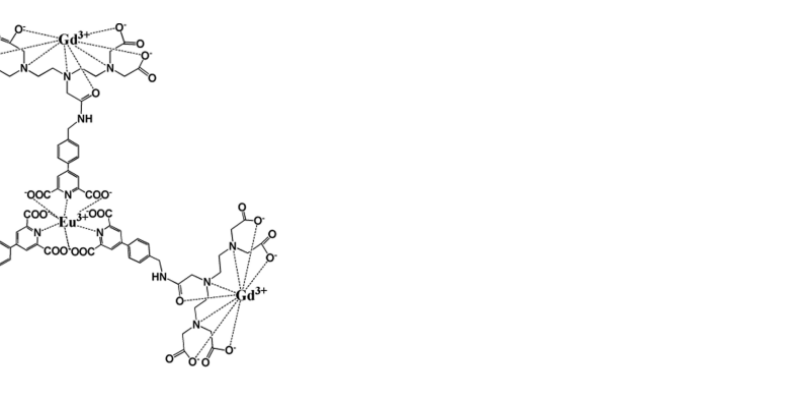
Figure 16. Schematic representation of the (GdL) 3 Eu, containing. Reproduced from [212], with permission from ACS Publisher, 2014.